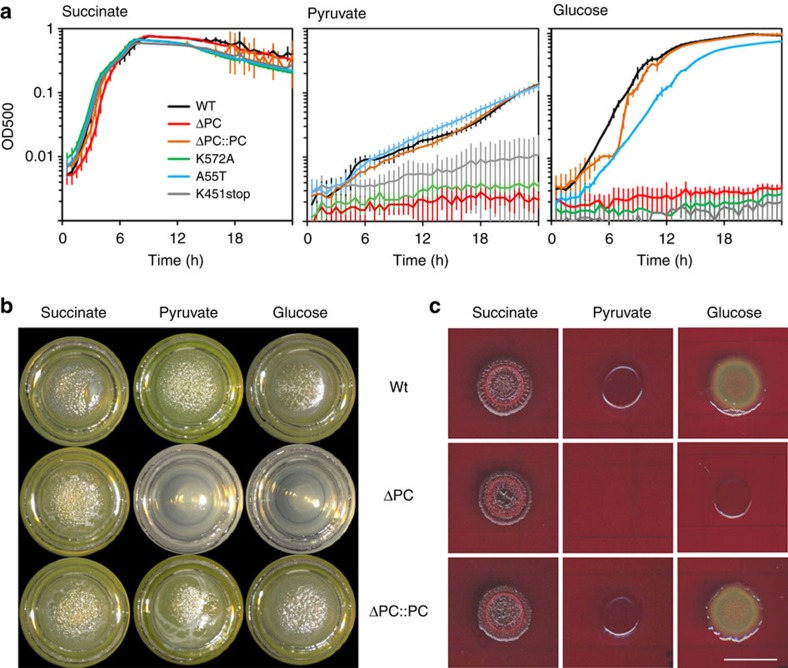
The two-subunit PaPC is required for growth on selected carbon sources.(a) Shaken liquid-culture growth of wild-type P. aeruginosa PA14, ΔPC, the PC-complemented strain and various site-specific mutants in a defined medium containing 20 mM succinate, pyruvate or glucose as the sole carbon source. Each growth curve represents the average of three biological replicates. Error bars denote s.d. (b) Pellicles formed by P. aeruginosa PA14, ΔPC, and the PC-complemented strain on a defined medium containing succinate, pyruvate, or glucose as the sole carbon source. (c) Colony morphology of P. aeruginosa PA14, ΔPC and the PC-complemented strain on a defined medium (supplemented with 1% agar, Congo red and Coomassie blue) containing succinate, pyruvate or glucose as the sole carbon source. Images depict day 3 of colony development.